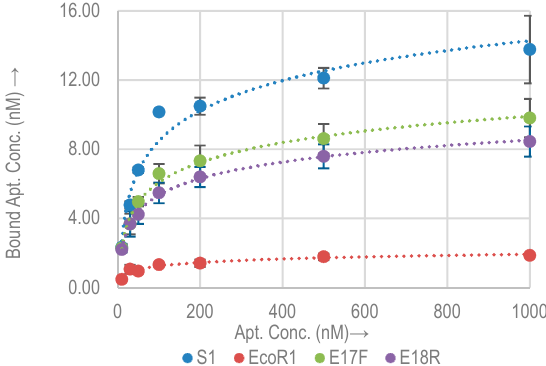
Figure 5. Binding isotherms for biotin tagged (5 ′ ) aptamers with E. coli O157:H7.